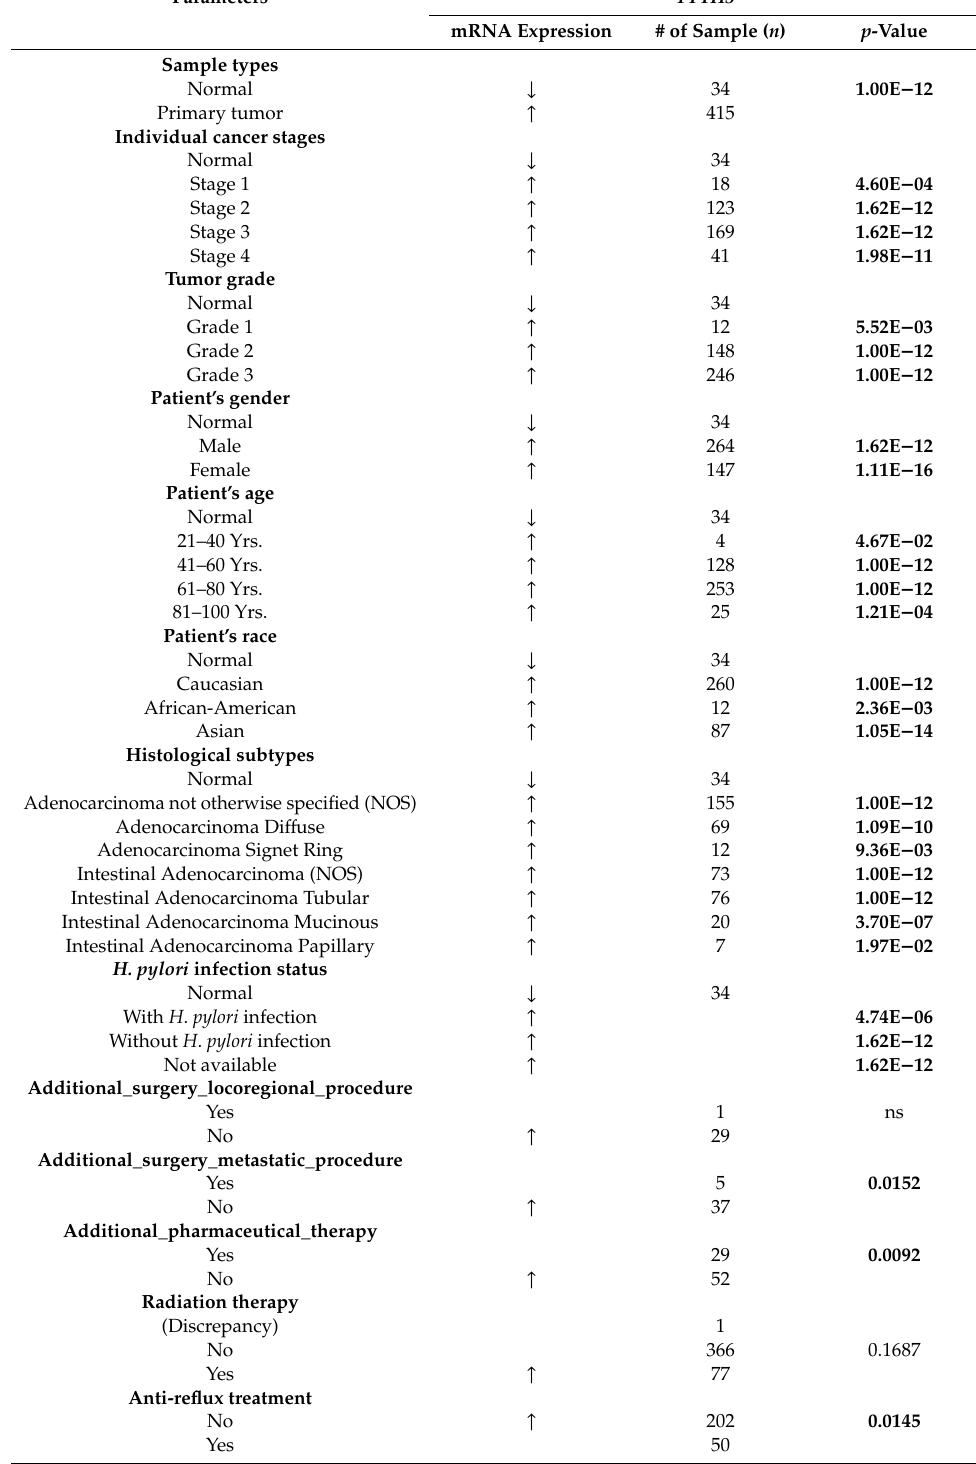
Table 1. The relationship between the TTYH3 and the clinicopathologic parameters of stomach cancer (TCGA